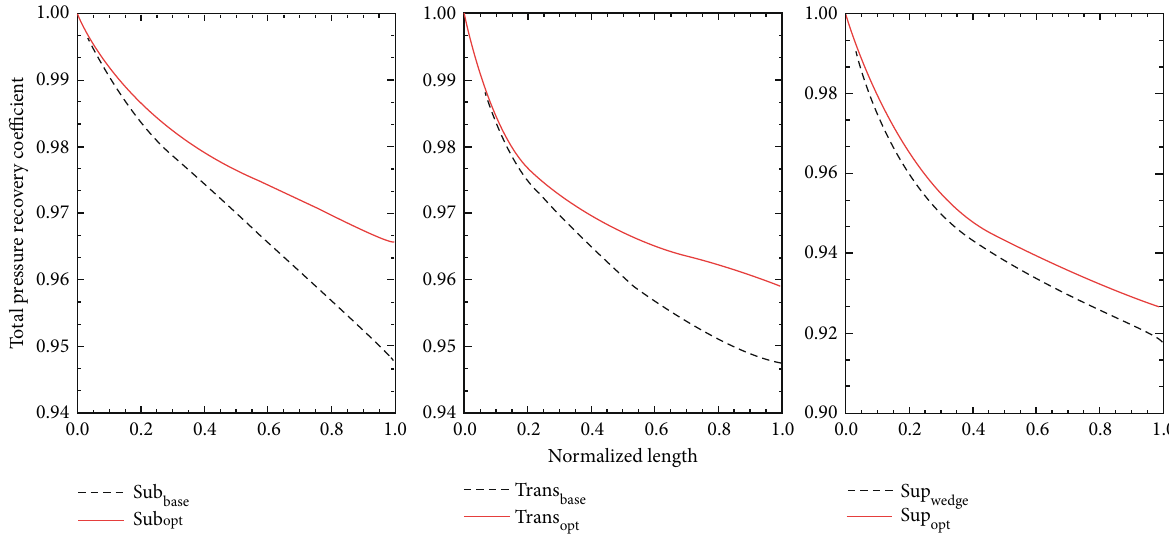
Figure 24: Total pressure recovery coe ffi cients of di ff users for di ff erent